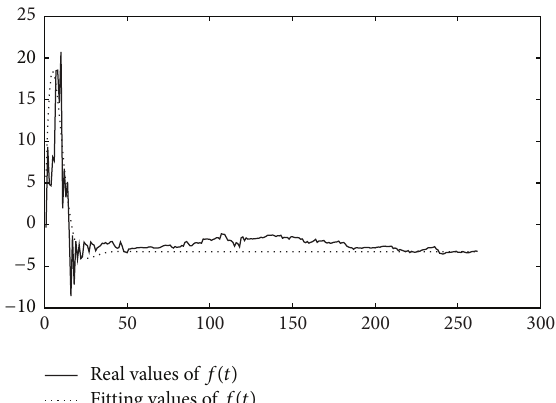
Real values of Fitting values of f(t) Figure 6: Real values versus fitting values of 𝑓(𝑡) during subprime